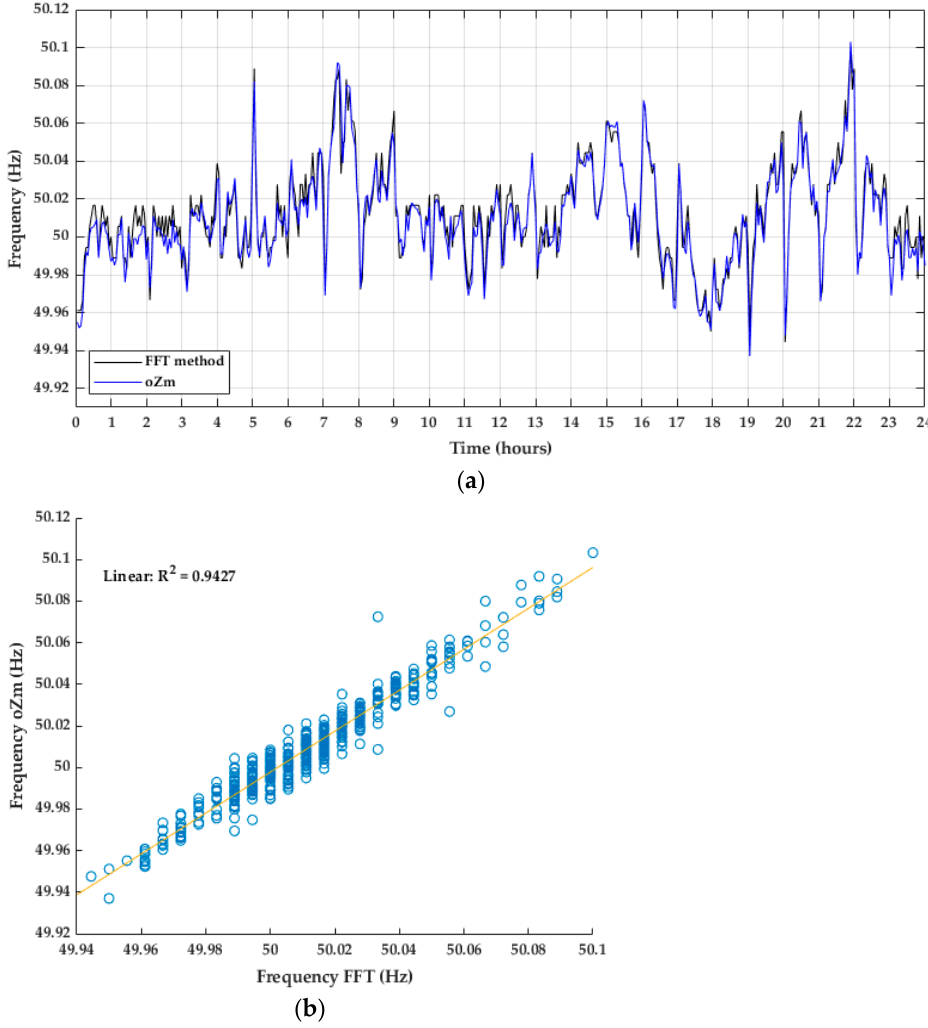
Figure 9. Comparison between the FFT method and the oZm. ( a ) Daily frequency of 3 May 2021; ( b ) Linear regression.